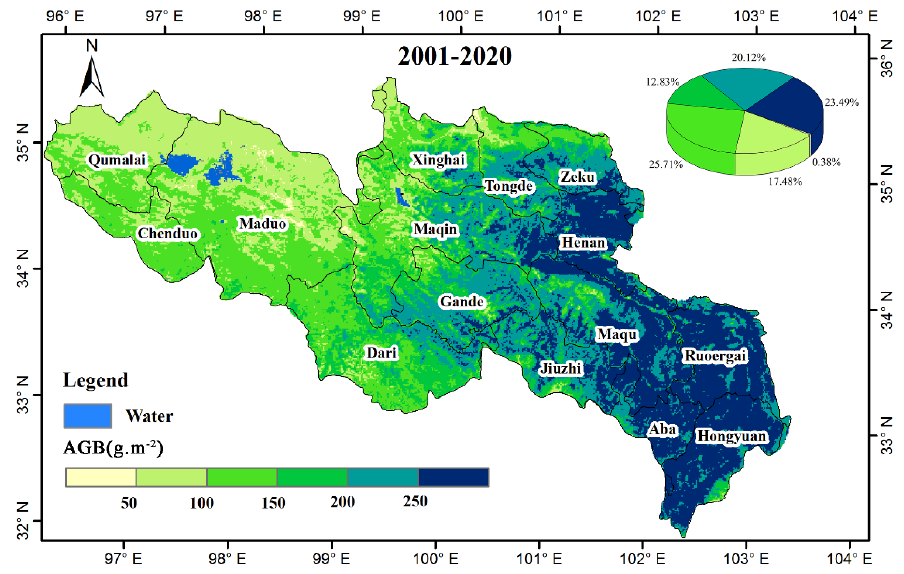
Figure 5. Spatial distribution of AGB in the HYR (the pie chart shows the proportion of AGB distribution ranges).